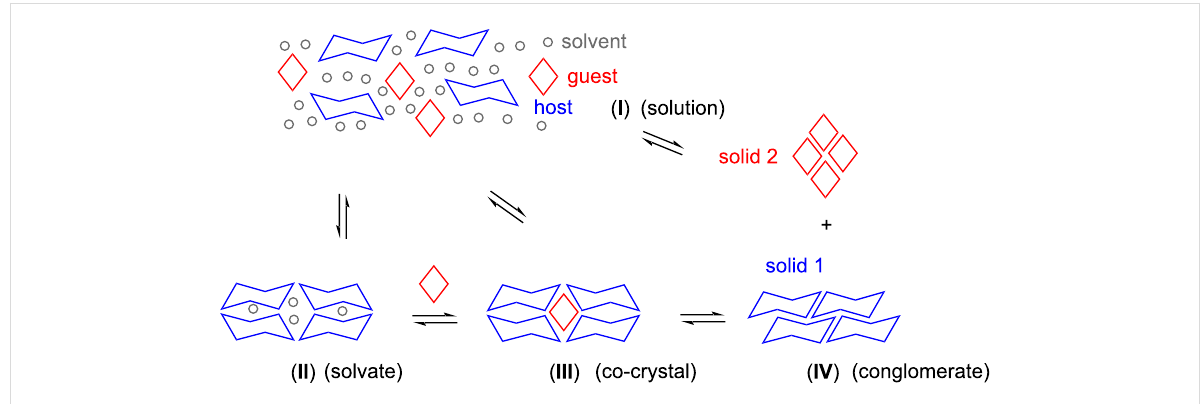
Figure 3: Possible states of two organic compounds capable of crystallizing at room temperature in a solvent. Colors used are blue for the chaperone, red for the smaller solid-forming organic compound, and gray for the solvent.